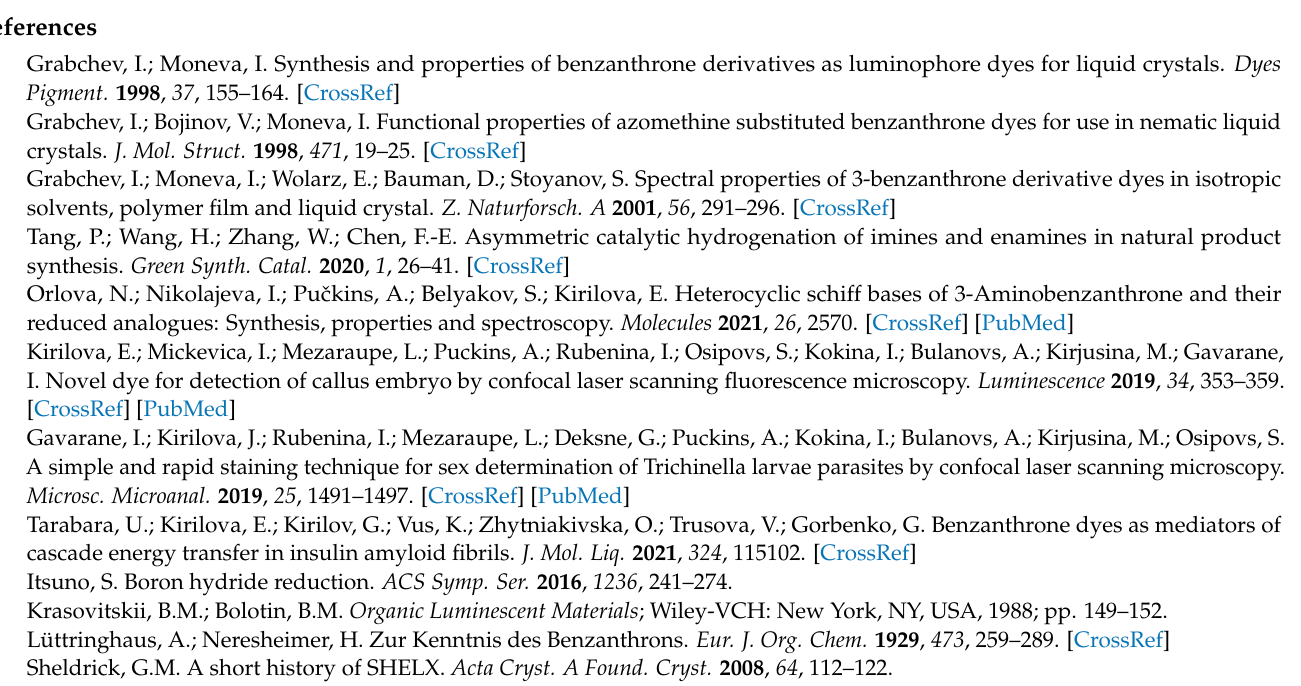
Figure S7: The absorption and emission (l exc = 500 nm) spectra of 3-[ N